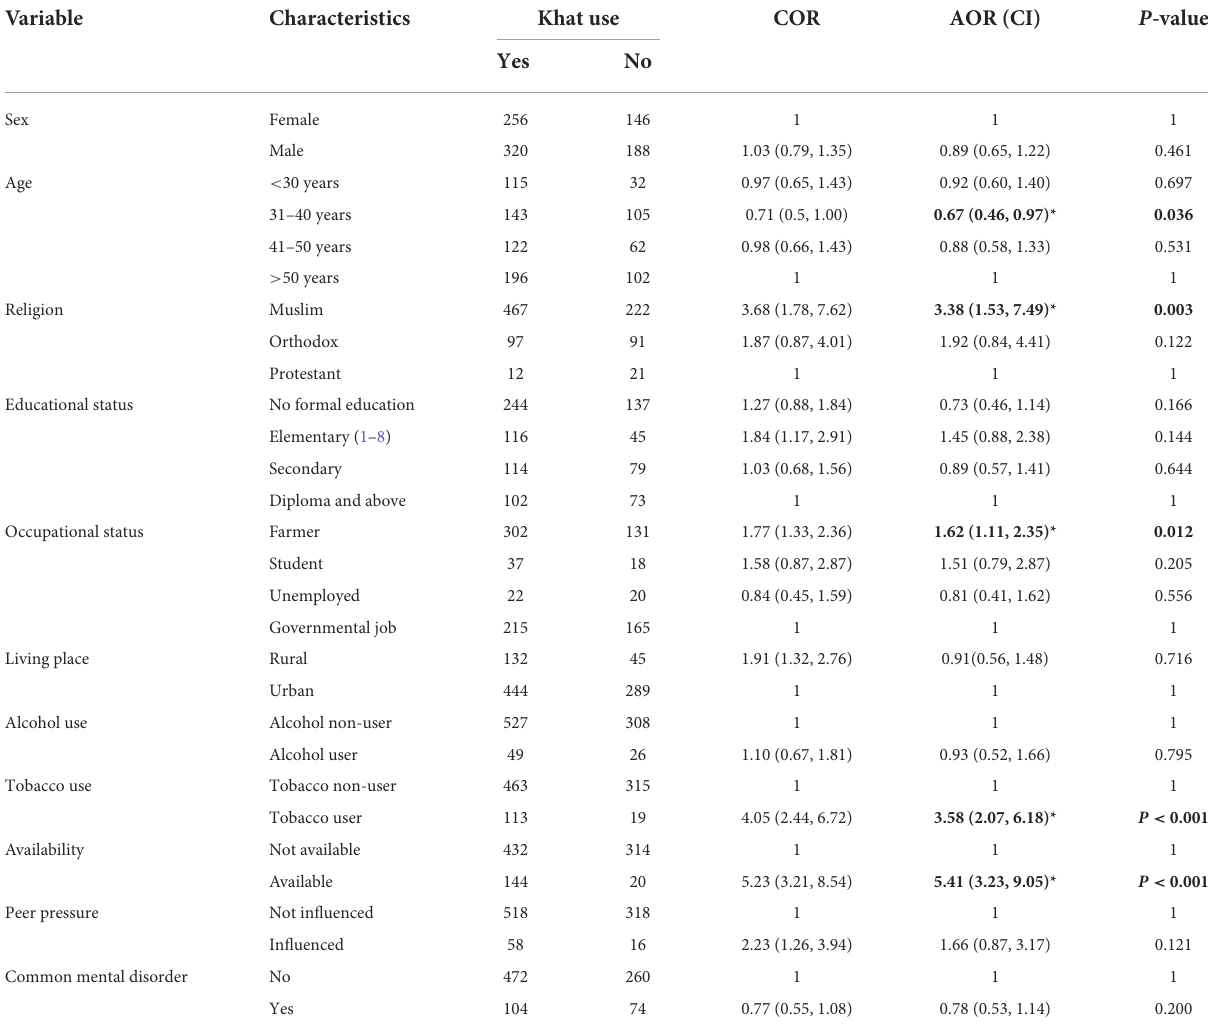
TABLE 4 Factors associated with khat use among adult residents of Harari regional state, Ethiopia, 2022 ( N = 910).